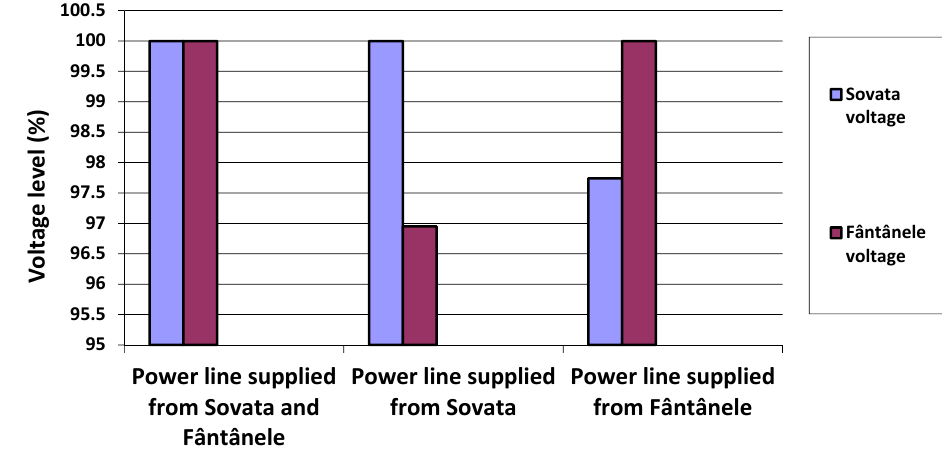
Figure 4. Voltage level (EVs not connected). Table 7. Bus voltages without EVs.